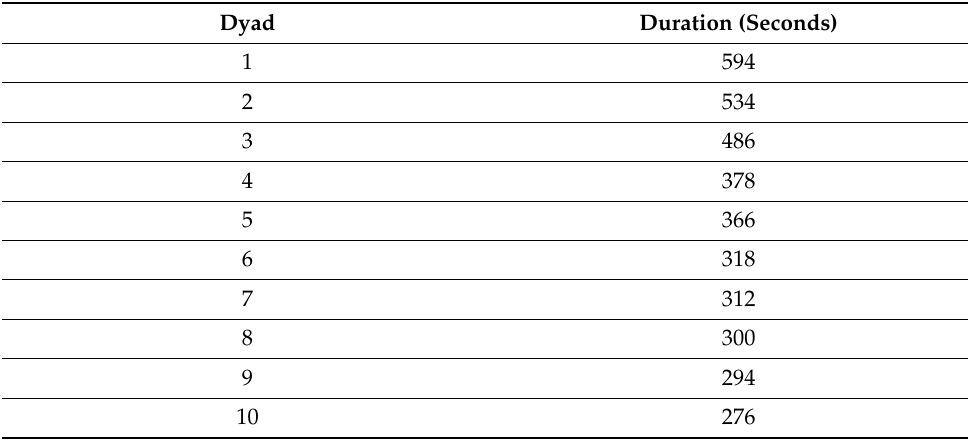
Table A4. Dyad-specific duration of the